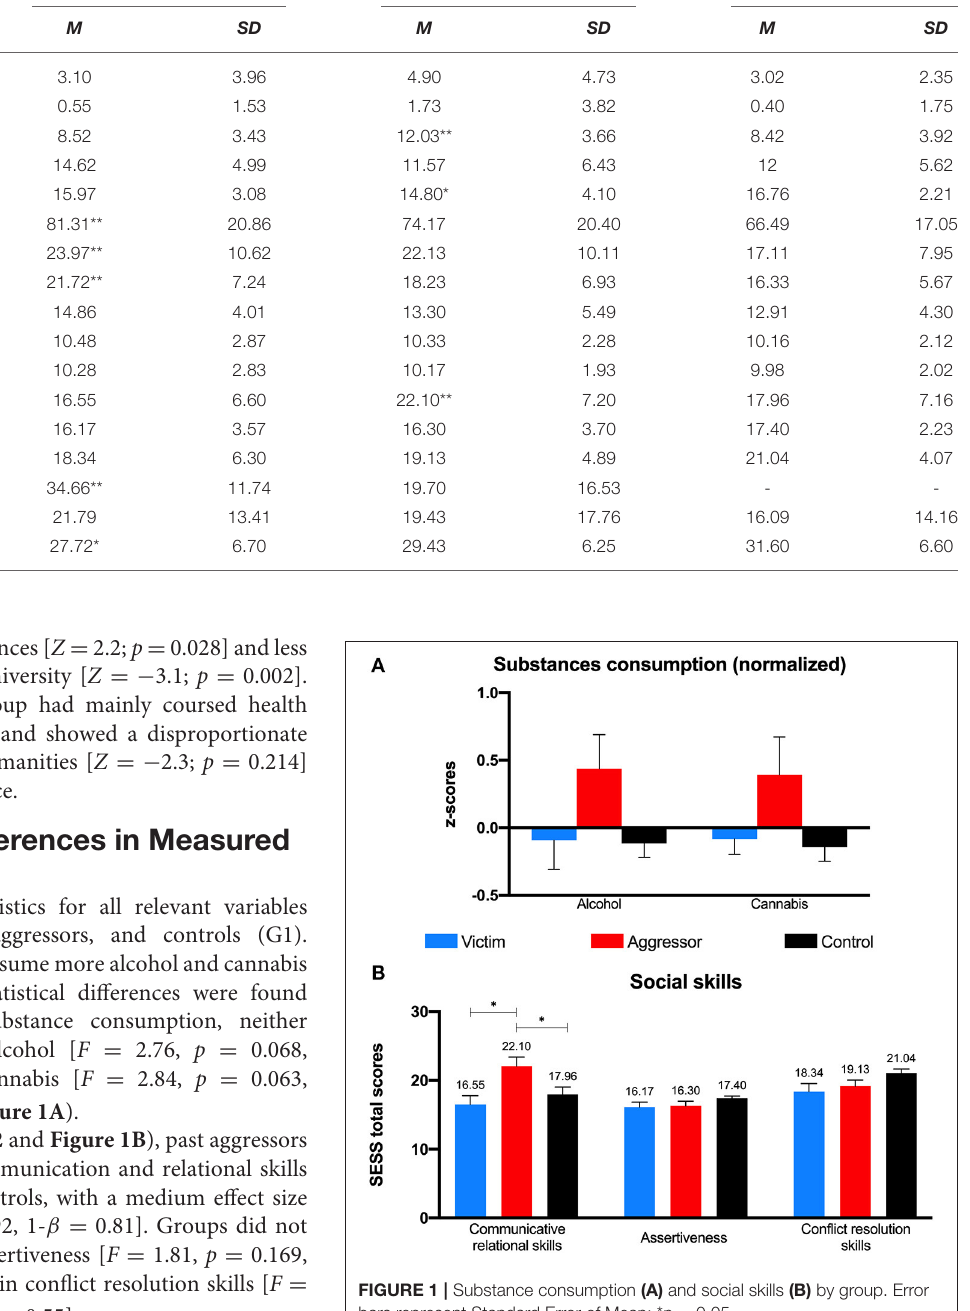
TABLE 2 | Descriptive statistics by group.